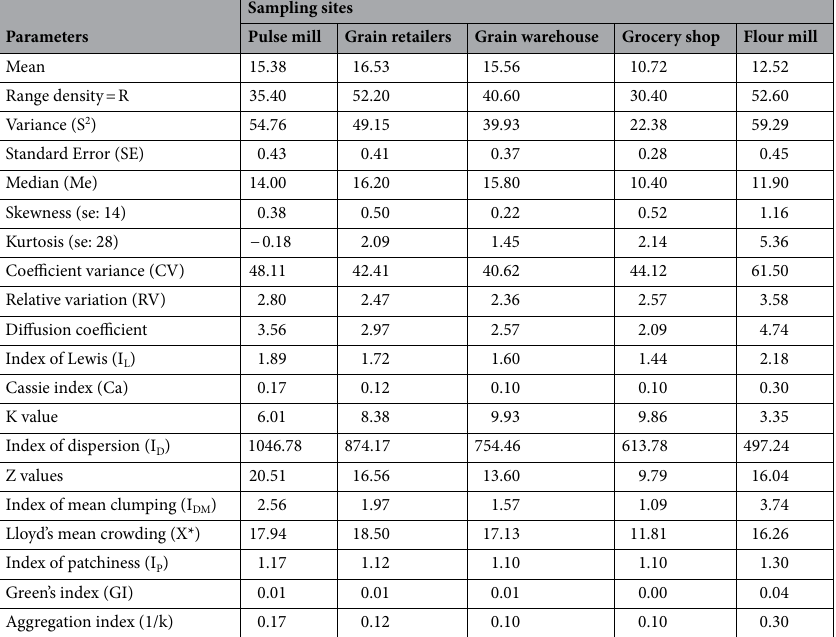
Table 1. Estimated parameters for spatial distribution of total population of Indian meal moth occurring in different food facilities at Rajshahi municipality area, Bangladesh during the five successive years (2014–2020).